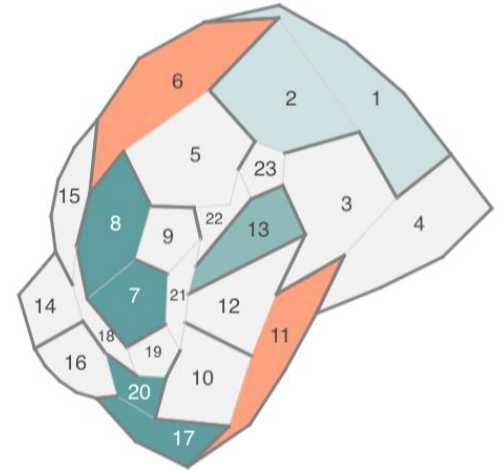
Figure 9. Planar graph.